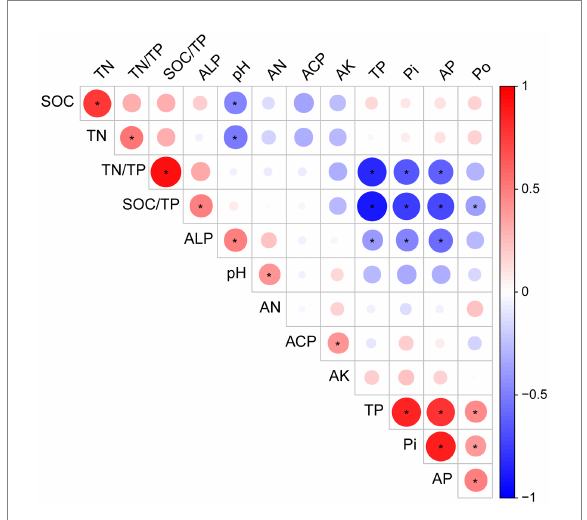
FIGURE 2 Correlation analysis of the soil properties of the alfalfa field under phosphorus fertilizer treatment. The red circle represents a positive correlation, while the blue circle represents a negative correlation. TP, total phosphorus; Po, organic phosphorus; Pi, inorganic phosphorus; AP, available phosphorus; TN, total nitrogen; AN, alkaline dissolved nitrogen; AK, available potassium; SOC, soil organic carbon; ALP, alkaline phosphatase activity; ACP, acid phosphatase activity; TN/TP, total nitrogen to total phosphorus ratio; SOC/TP, soil organic carbon to total phosphorus ratio. The color intensities indicate correlation coefficients between − 1.0 and 1.0. The asterisk “*” represents significant correlation at significance level of p <